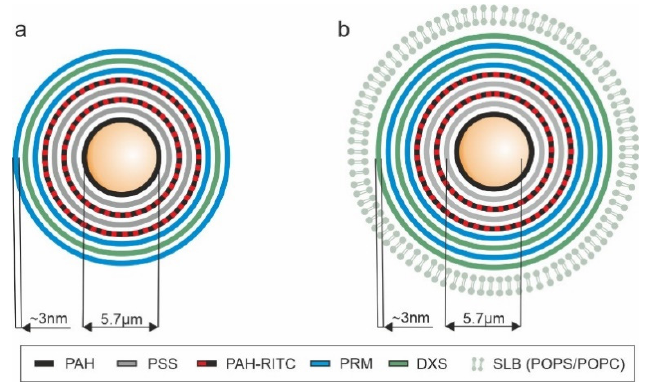
Figure 1. Illustration of the polymer and SLb microcarrier coating schemata. In ( a ) the polymer coating ending with negatively charged DXS (polymer microcarrier) is shown, ( b ) demonstrates microcarriers with a final SLB (POPS/POPC 1:1, POPS: anionic, POPC: zwitterionic) assembly on top of a positively charged polymer layer (SLB microcarriers).